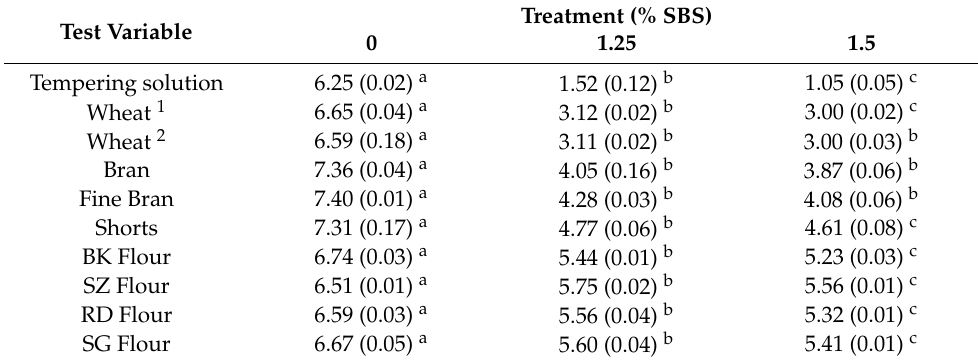
Table 3. Mean (sd) pH values for the wheat milling